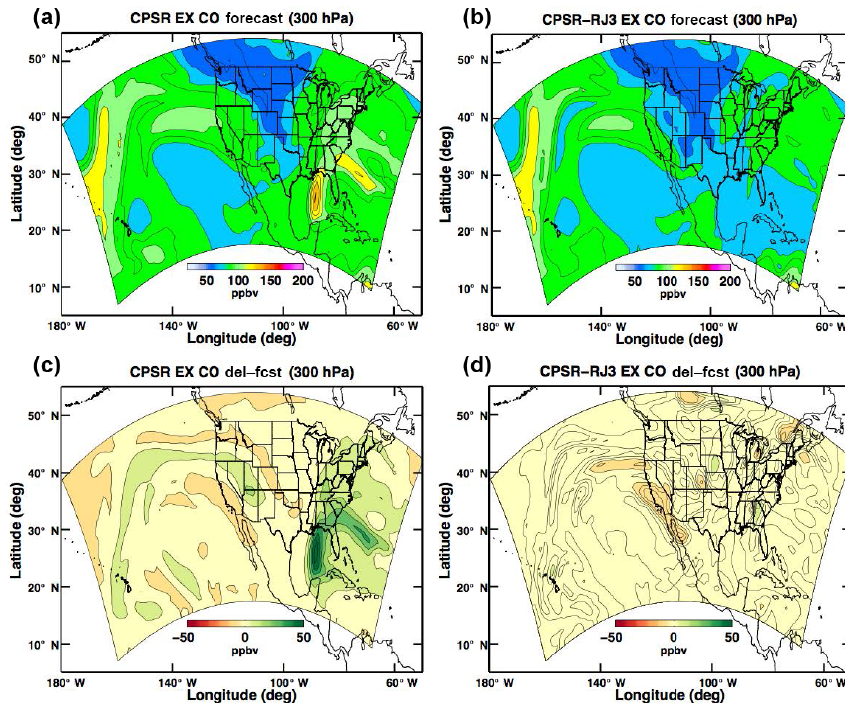
Figure 10. Same as Fig. 9 except for ∼ 300hPa.